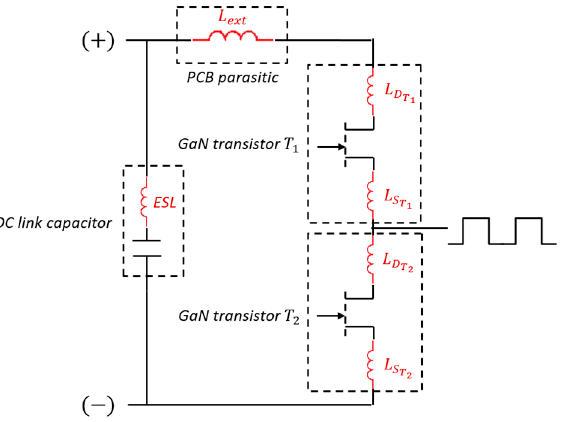
Figure 1. Parasitic inductances identification in the commutation loop on printed circuit board (PCB).